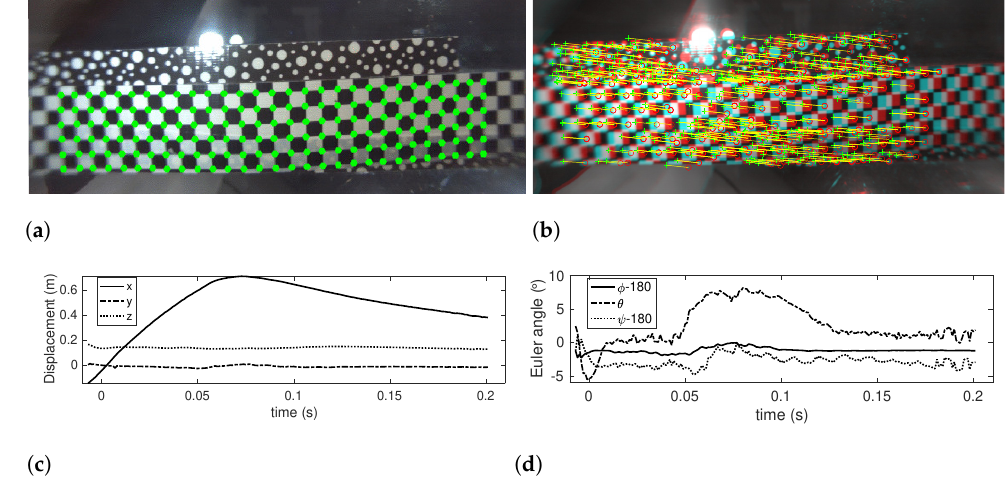
Figure 10. Results of camera pose estimation using computer vision